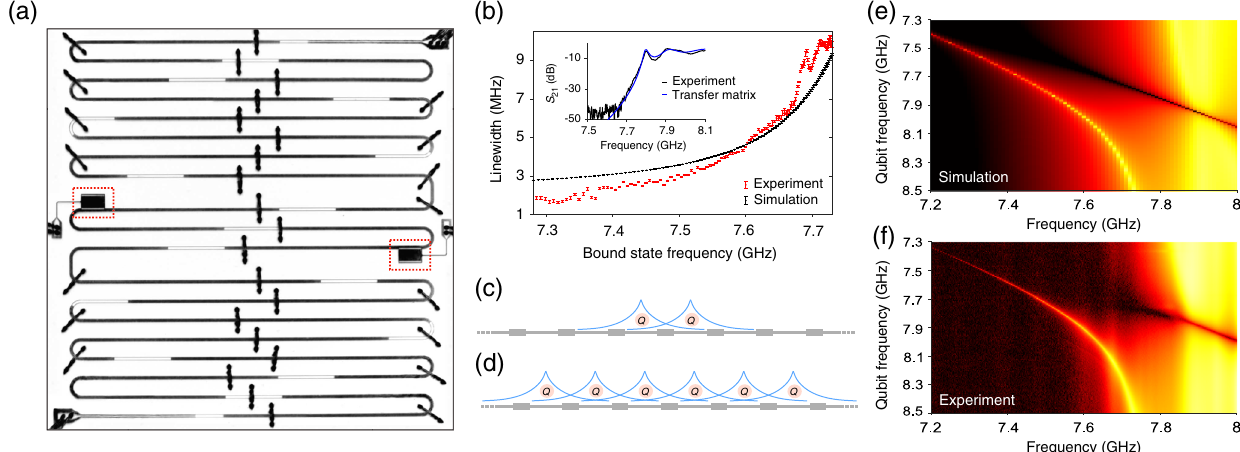
FIG. 1. A platform for interacting dressed bound states . — (a) A 16-site microwave photonic crystal is realized by alternating sections of high and low impedance coplanar waveguide. Two transmon qubits (multilevel, anharmonic energy ladder) are in neighboring unit cells in the middle of the device, centered in the high impedance sections for maximal coupling to the band edge at 7.8 GHz [all values 7 . 8 ð 2 π Þ GHz]. For this experiment, the passband (band gap) refers to states above (below) the presented in units of ð 2 π Þ Hz, i.e., ω BE ¼ band-edge frequency. Each transmon is individually tunable in frequency via a local flux bias line. (b) Bound-state linewidth, an indirect measure of localization, varies with bare transmon qubit frequency. The wide range over which photon localization can be tuned indicates the feasibility of realizing a chain of strongly interacting bound states. Experimentally measured and simulated linewidths are shown in red and black, respectively. Inset: Overlay of simulated S 21 from the transfer matrix method (blue) and measured high-power S 21 (black) shows good agreement in bare crystal characteristics. (c) The interaction between bound states will be determined by overlap of their localized photonic envelopes with the qubits. (d) One can couple more qubits to the band edge by adding them to other cells of the photonic crystal. In such a system, the localization-length-dependent interaction of the bound states would preserve the spatial organization of qubits across the crystal, and determine the many-body structure of the interactions. (e) Experimental data and (f) hopping model simulation for S 21 vs single-qubit frequency and probe frequency. The bare band edge is at 7.797 GHz. The bright peak in the band gap is the dressed qubit-photon bound state. The bound state always exists within the band gap for qubit frequencies (the other qubit is far detuned and has negligible effect) both above and below the band edge — a clear signature of